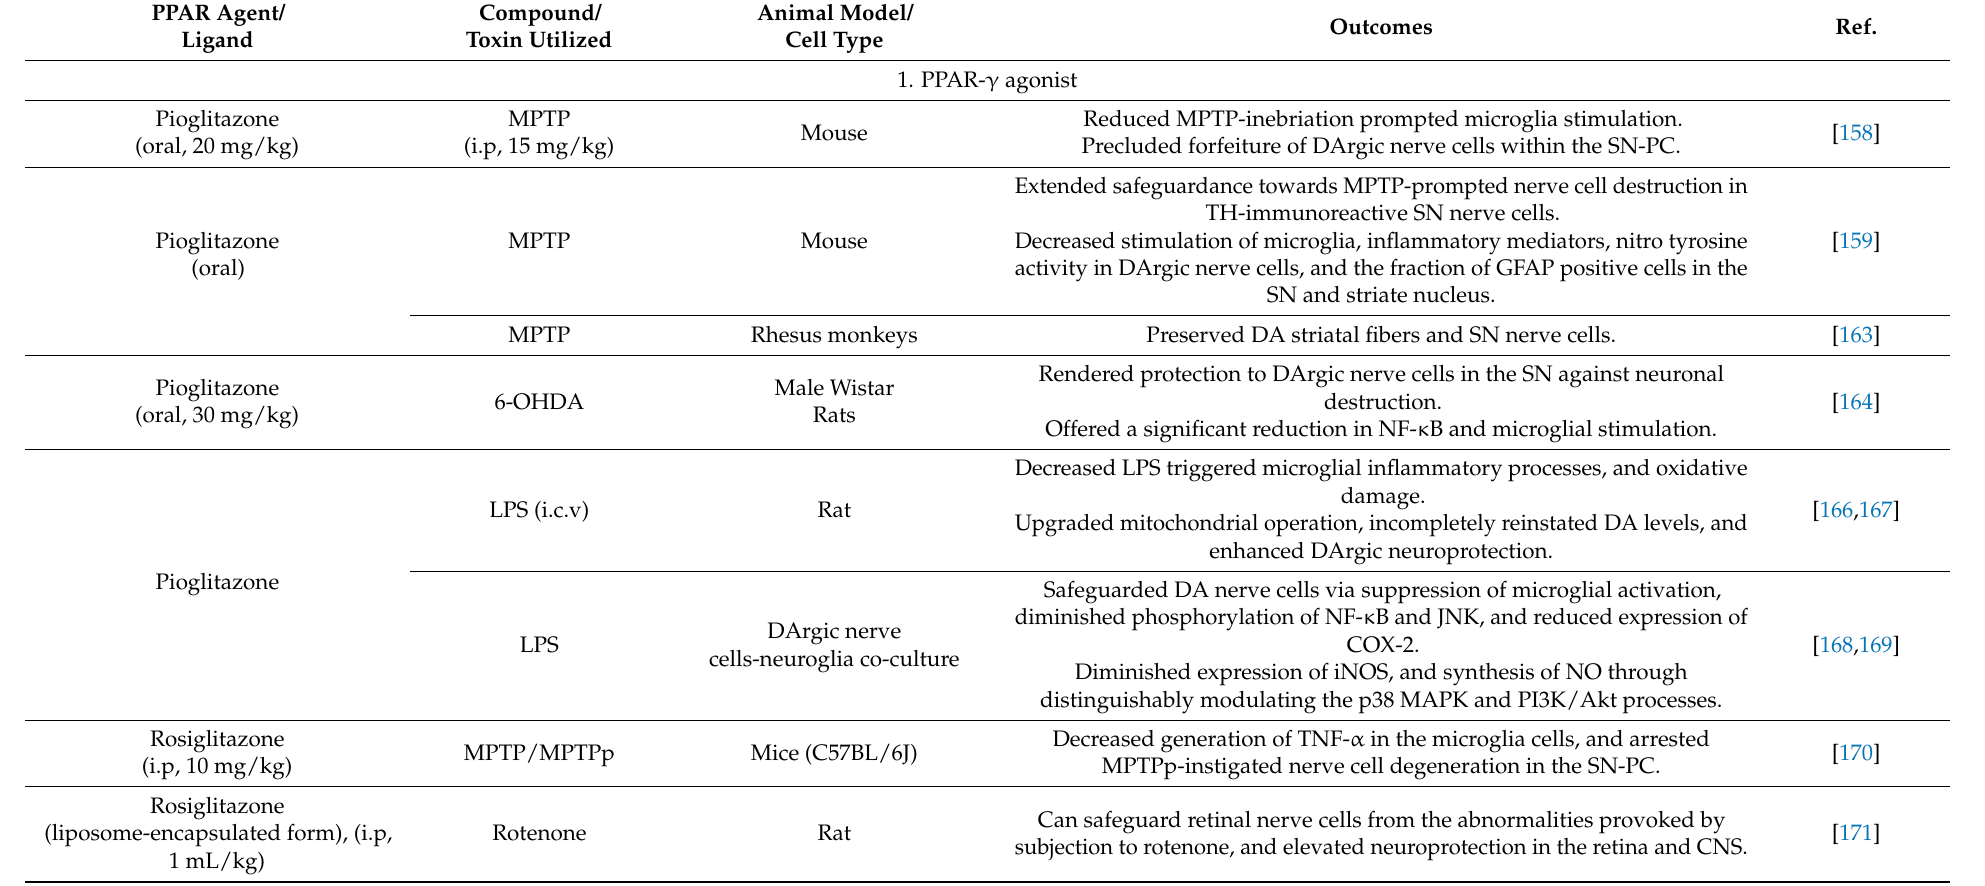
Table 1. The neuroprotective outcomes of PPAR agonists in Parkinson’s